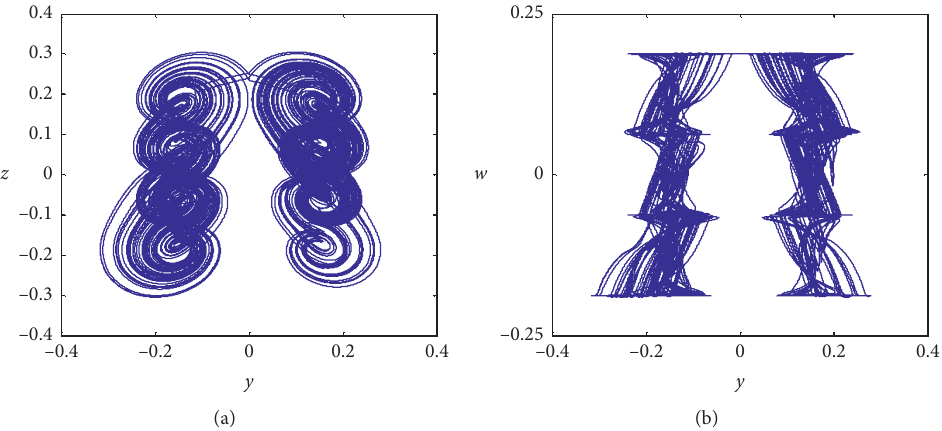
Figure 10: Numerical simulations for the chaotic system n � 1. (a) y versus z ; (b) y versus w .